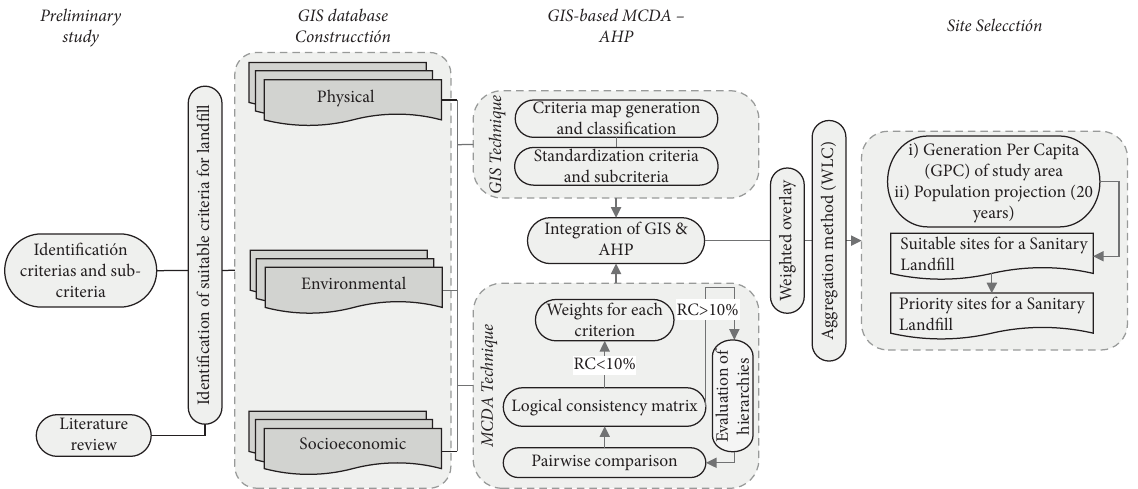
Figure 2: Methodological flowchart for determining suitable landfill